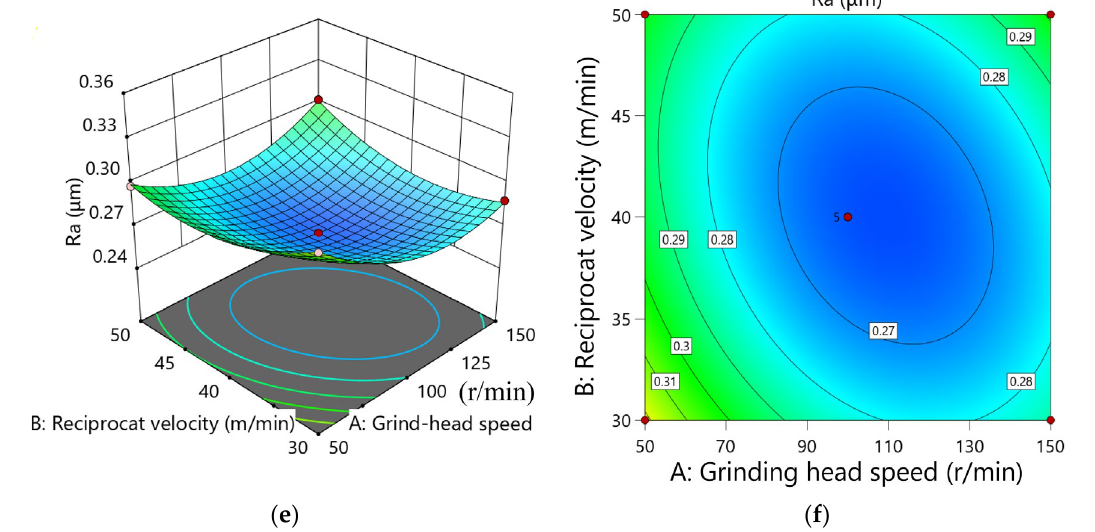
Figure 8. Response surface plot and projected contour plot of interaction. ( a ) Response surface of grinding depth and grinding head speed when the reciprocat velocity is 40 m/min. ( b ) Contour of grinding depth and grinding head speed when the reciprocating velocity is 40 m/min. ( c ) Response surface of grinding depth and reciprocating velocity when the grinding head speed is 97 r/min. ( d ) Contour of grinding depth and reciprocating velocity when the grinding head speed is 97 r/min. ( e ) Response surface of grinding head speed and reciprocating velocity when the grinding depth is 0.010 mm. ( f ) Contour of grinding head speed and reciprocating velocity when the grinding depth is 0.010